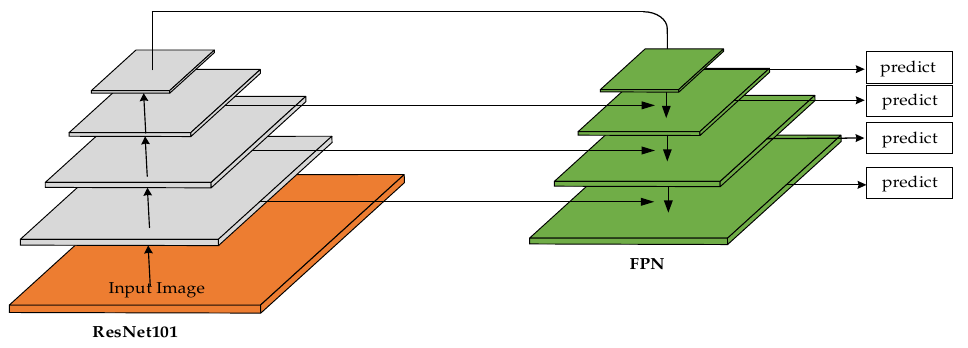
Figure 2. Feature Pyramid